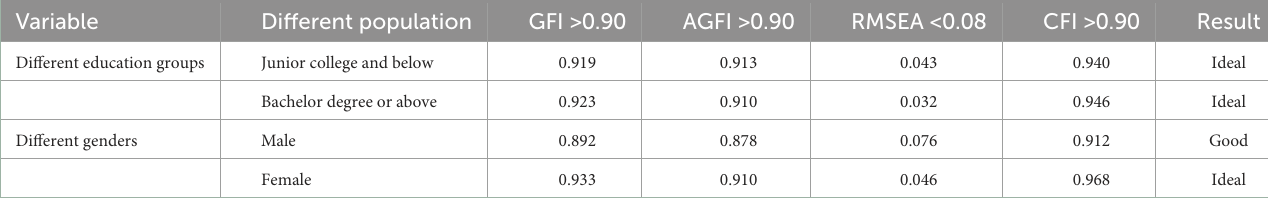
TABLE 7 Comparison of parameters between different groups.